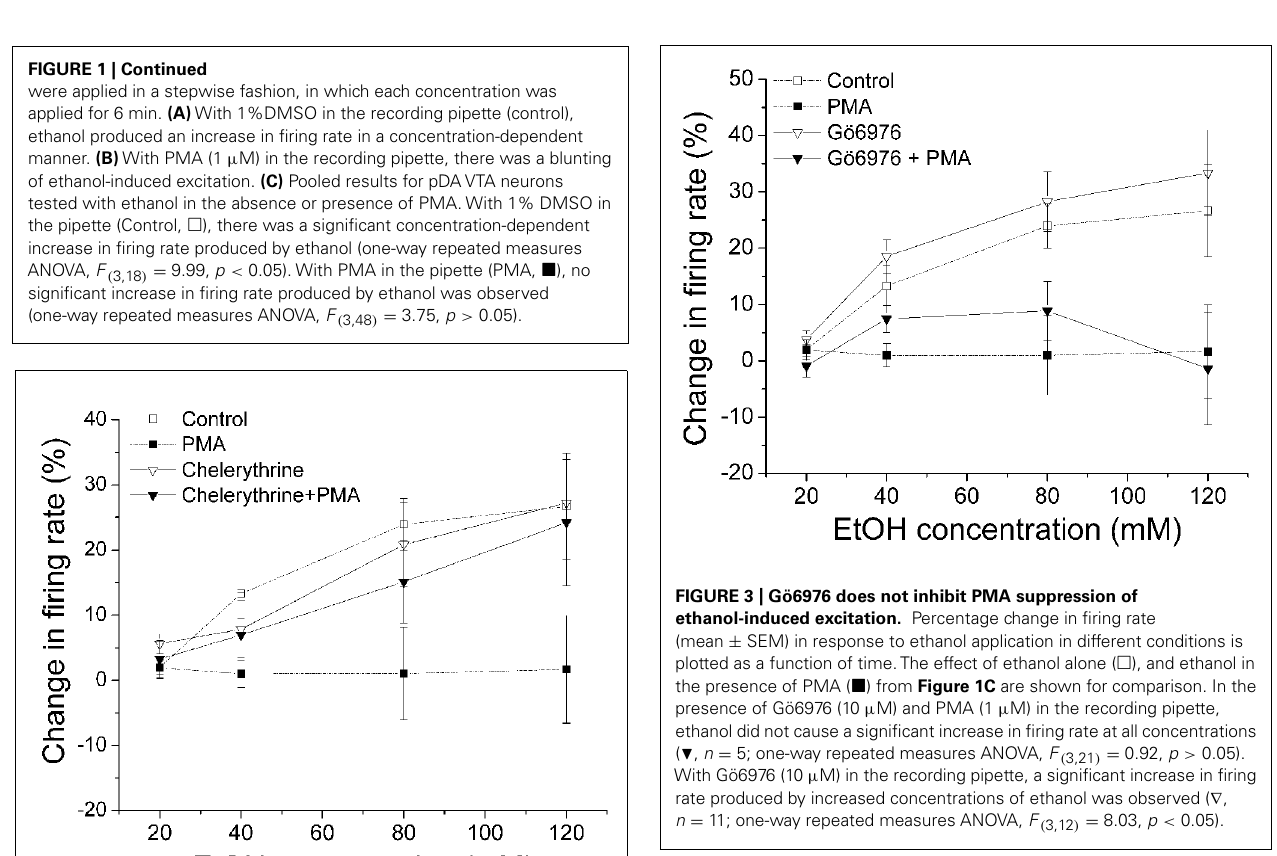
FIGURE 2 | Chelerythrine inhibits PMA suppression of ethanol- induced excitation. Percentage change in firing rate (mean ± SEM) in response to ethanol application under different conditions is plotted as a function of time.The effect of ethanol alone ( (cid:2) ), and ethanol in the presence of PMA ( (cid:3) ) from Figure 1C are shown for comparison.With chelerythrine (10 μ M) in the bath and PMA (1 μ M) in the recording pipette, there was a significant increase in firing rate produced by increased concentrations of ethanol ( (cid:4) , n = 15; one-way repeated measures ANOVA, F ( 3,42 ) = 5.64, p < 0.05).With chelerythrine (10 μ M) in the bath and 1% DMSO in the pipette, ethanol produced a significant concentration-